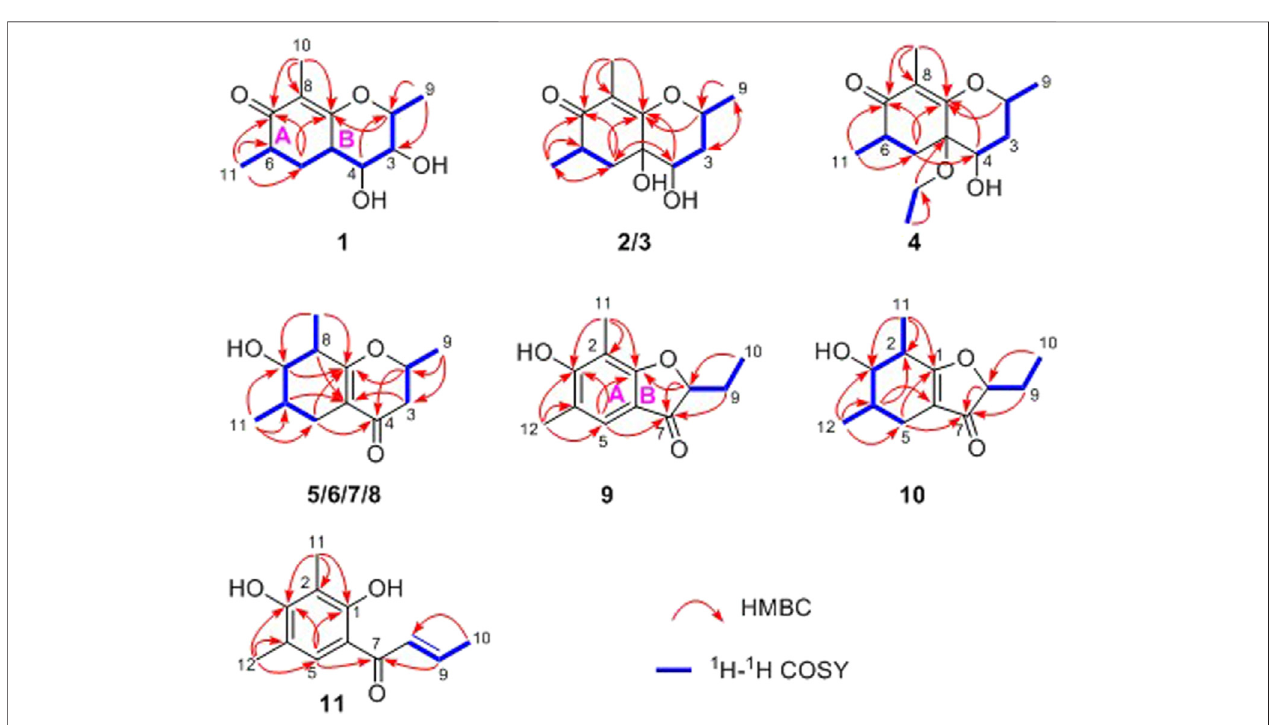
FIGURE 2 | Key 1 H- 1 H COSY and HMBC correlations of compounds 1 – 11.